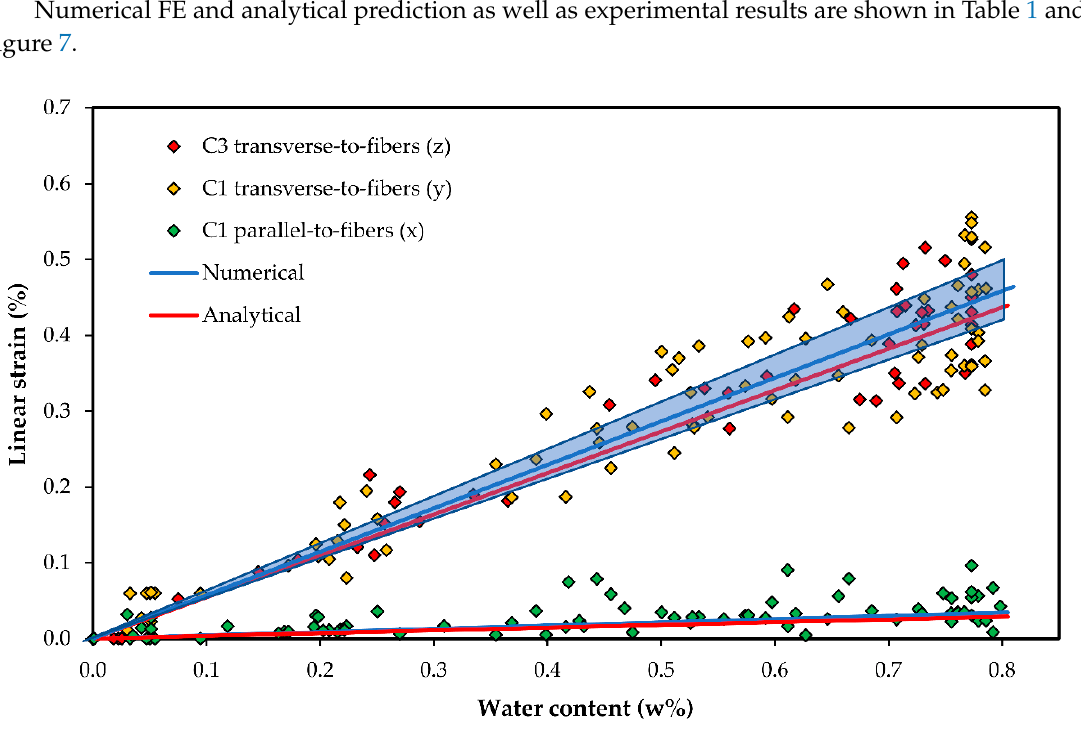
Figure 7. Numerical and analytical fit of swelling with the experimental data for composites. Analytical results are shown in red lines; global averaged out numerical results are shown in blue lines, while a numerical scatter is shown with blue sectors indicating scatter on the local scale due to various fiber arrangements. Table 1. Coefficients of hygroscopic expansion. Experimental scatter is reported with one standard deviation for the coefficient of hygroscopic expansion (CHE). * indicates an input parameter for the models.